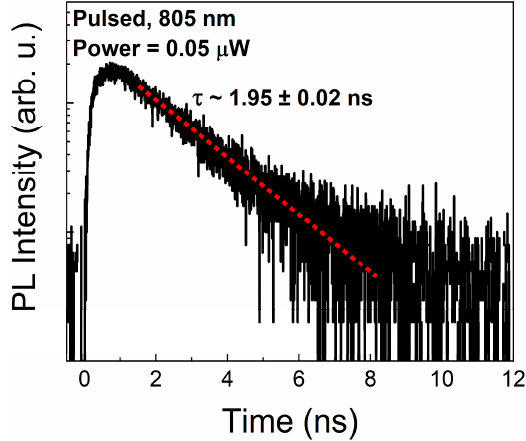
Figure 4. The time-resolved µ PL trace for the CX line at low excitation power of 0.05 µ W. The red dotted line indicates a mono-exponential fit to the experimental data.